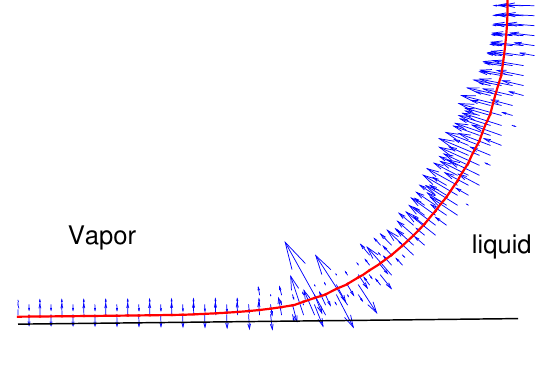
Figure 10. Mass flux around the interface: the red line is the interface of liquid and vapor, the vapor is at the left side and the liquid is at the right side; the black line is the solid wall; the vectors with arrows indicate the local mass fluxes that are normal to the interface, and the vector norms are proportional to the mass